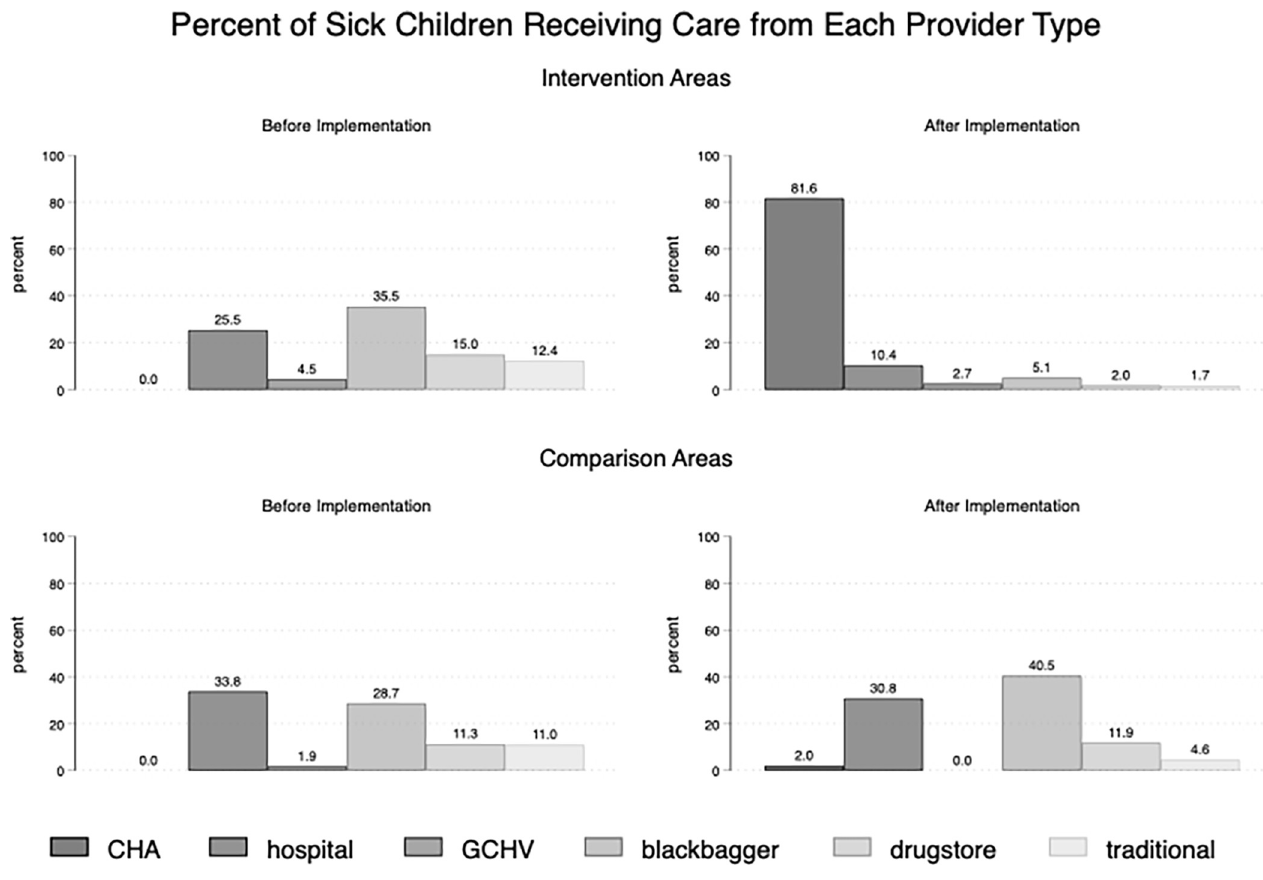
Fig 2. Percent of sick children receiving care from each provider